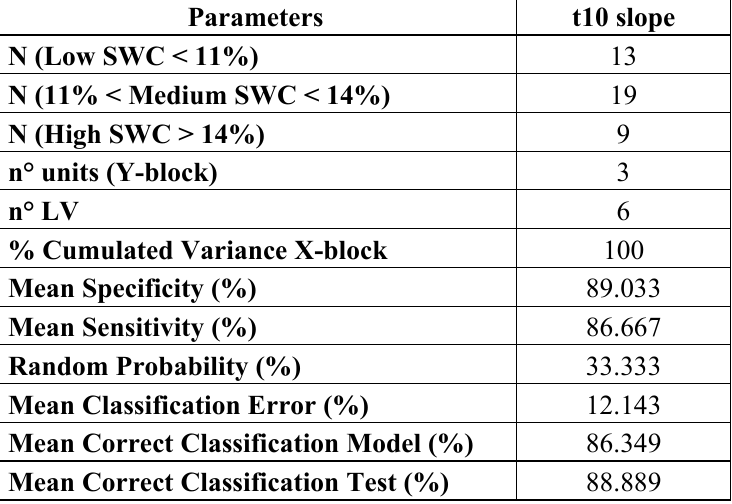
Table 5. Results of Partial Least Squares Discriminant Analysis (PLSDA) for the in-field prediction of SWC obtained with thermometric analysis for the interval t slope considering three different classes of soil water content (SWC) (low < 11%; 11% < medium < 14% and high > 14%). N is the number of samples; n° units (Y-block) is the number of units to be discriminated by the PLSDA; n° LV is the number of latent vectors. Random Probability (%) is the probability of random assignment of an individual into a